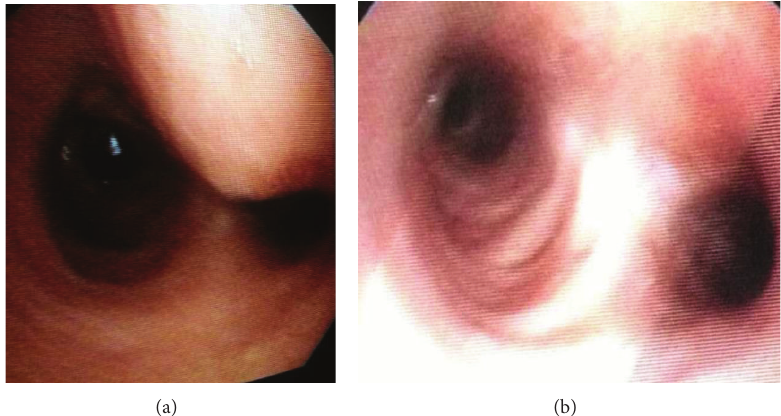
Figure 3: Bronchoscopic view of the trachea at the main carina level. (a) There is an extrinsic pressure on the distal part of trachea and the right main stem bronchus. (b) After the screw was removed and replaced by a 10mm shorter, the right main bronchus seems open, and there is no endoluminal sign of tracheal